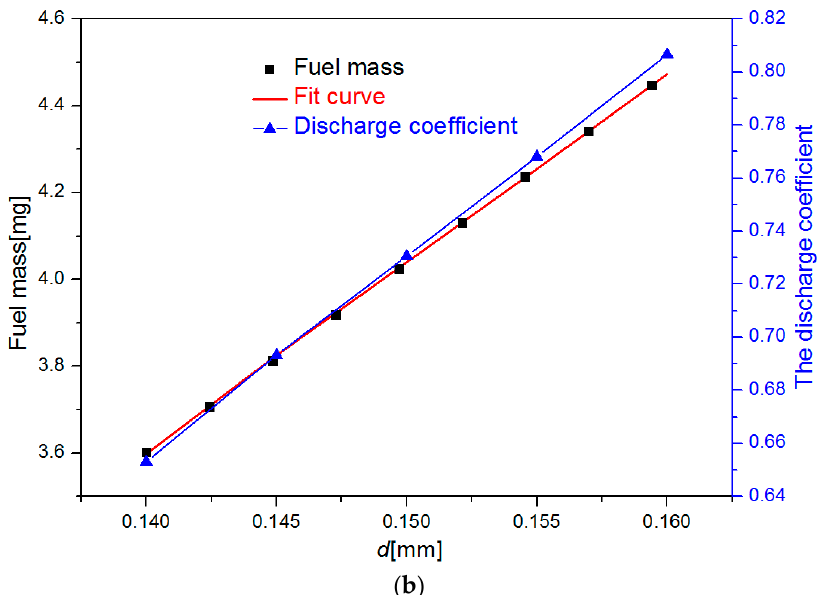
Figure 8. The effect of injector nozzle diameter on injection characteristics of GDI injector. ( a ) The effect of nozzle diameter on injection law , ( b ) The effect of nozzle diameter on the fuel mass.